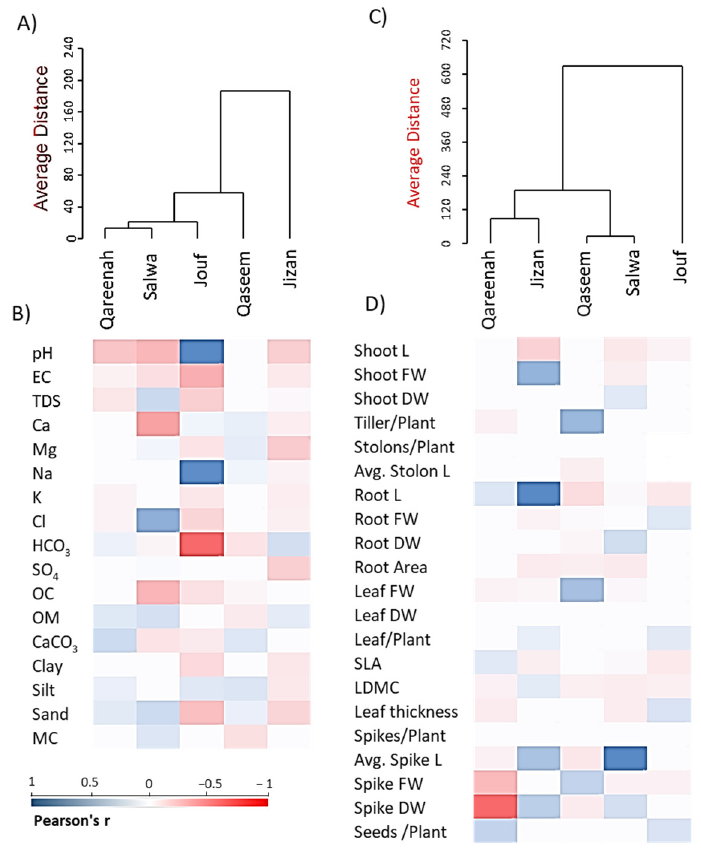
Figure 10. Agglomerative hierarchical clustering (AHC) and heatmaps of the studied parameters within different saline flat regions of Aeluropus lagopoides . ( A ) AHC and ( B ) heatmap based on the soil variables, ( C ) AHC and ( D ) heatmap based on the morphological and reproductive traits. EC: